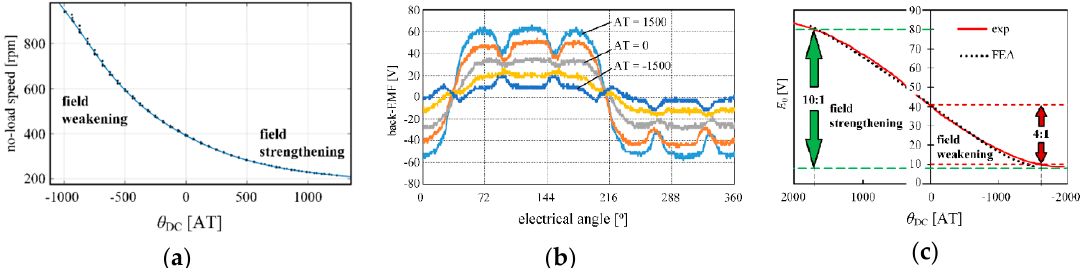
Figure 5. ( a ) Experimental results of no-load speed obtained at constant DC-bus voltage of 100 V; ( b ) Back-EMF waveforms at 1000 rpm rotor speed; ( c ) Characteristics of no-load phase output voltage at the different DC coil MMF of ECPMS-machine [54].